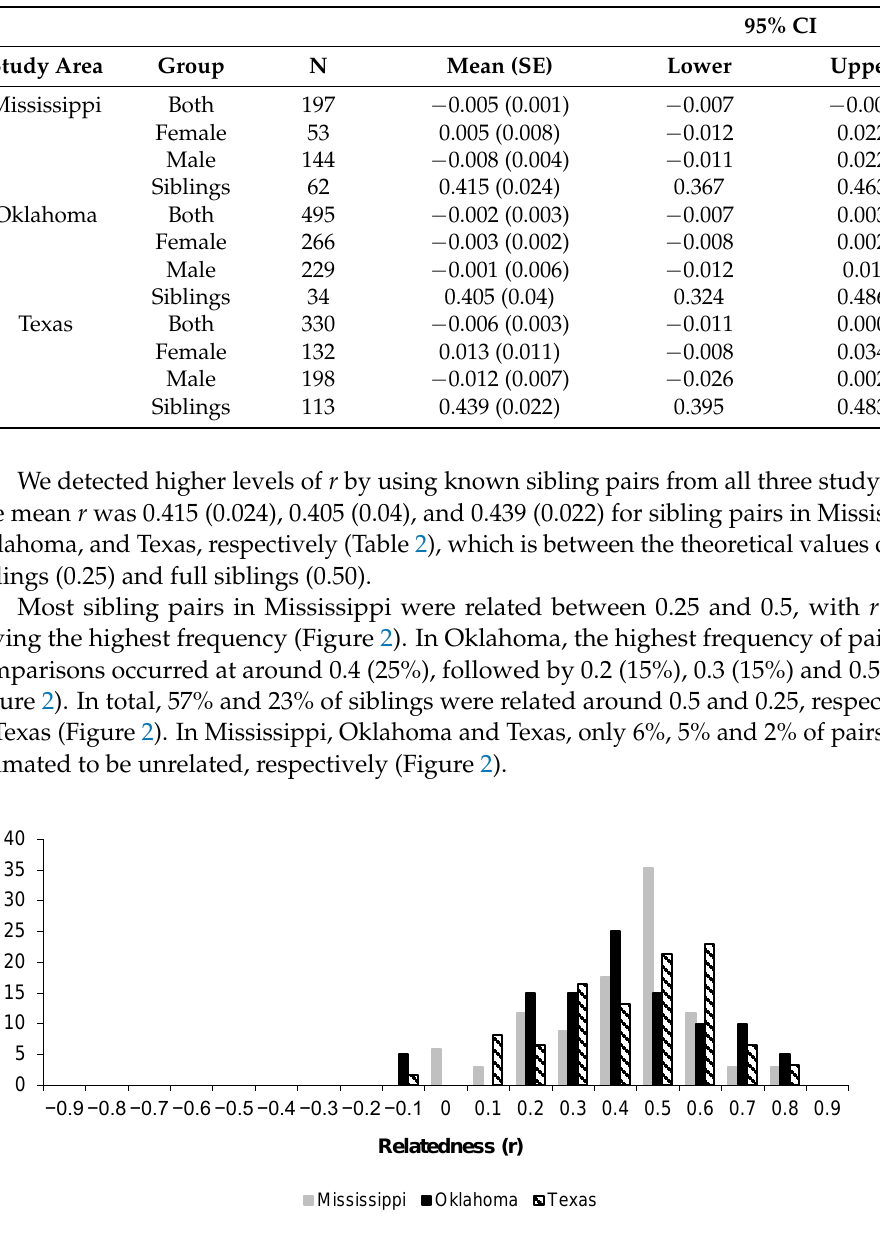
Figure 2. Distribution of pairwise relatedness ( r ) estimates of known sibling pairs of white-tailed deer ( Odocoileus virginianus ) from Mississippi (1999–2001), Oklahoma (1991–2005) and Texas (1999–2005). All antler groupings (i.e., antler points and score, non-typical points and antler malfor- mations) were unrelated regardless of age or study area because the 95% CI values included zero or were <0 (Table A1). The confidence intervals of all antler group comparisons over- lapped; therefore, there was no difference between antler groups (Table A1). We compared distributions of antler groupings (i.e., antler points and score and non-typical points) to known sibling pair distributions and sex-specific distributions as a reference. Distributions of pairwise r were normally distributed around x = 0 and did not show bimodal or skewed